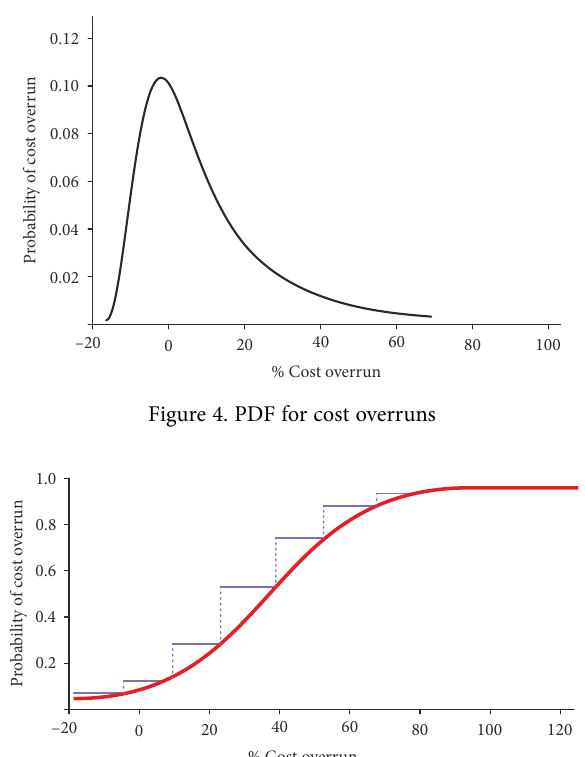
Figure 5. CDF for cost